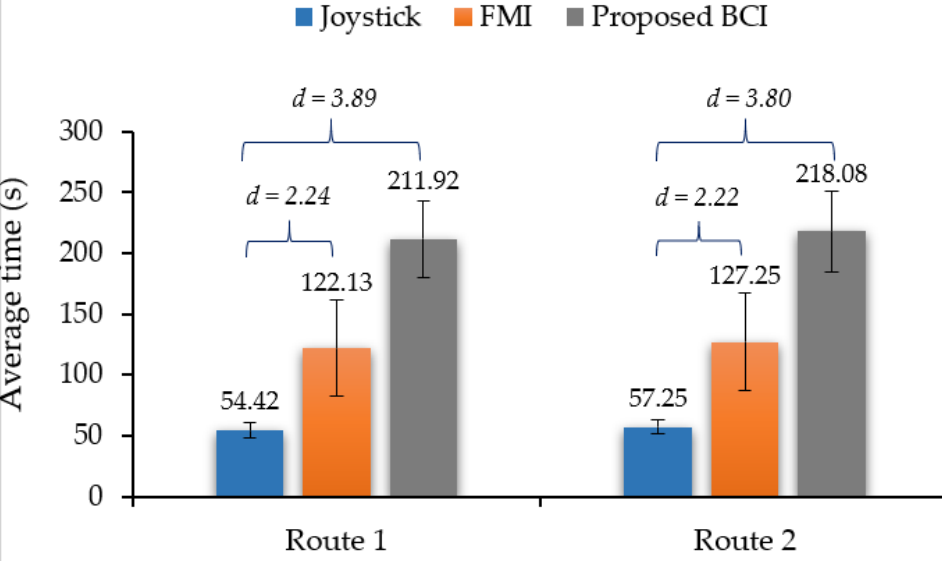
Figure 9. Comparison of average times to complete all routes using the proposed and traditional systems ( d = time difference ratio).